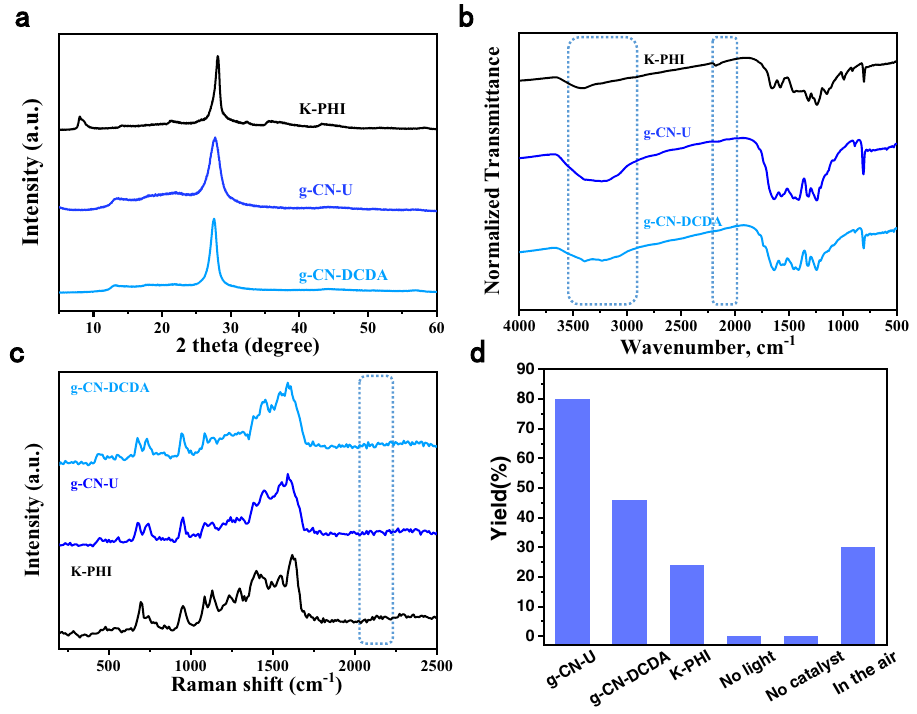
Fig. 2 | Structuralcharacterizations.a PXRDresultof g-CN-U, g-CN-DCDA, K-PHI. b FT-IR spectra of g-CN-U, g-CN-DCDA, K-PHI. c Raman spectra of g-CN-U, g-CN- DCDA, K-PHI. d Photocatalytic activities under the different photocatalysts: 1a